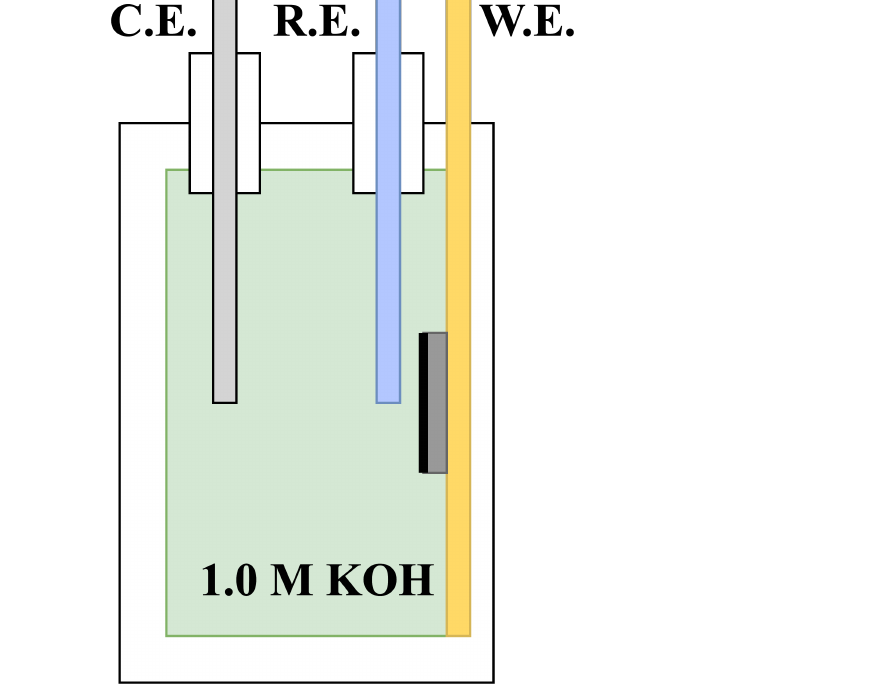
Figure 1. An efficient three-electrode setup with a platinum wire counter electrode (C.E.), an extended Luggin probe connected to a Ag/AgCl reference electrode (R.E.), and a catalyst-coated nickel foam working electrode (W.E.) attached to a gold plate to decrease ohmic losses. All electrochemical characterisation was performed in 1.0 M KOH at room